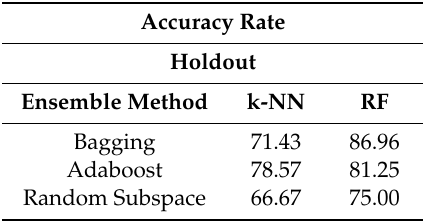
Table 7. Overall performance measure ensemble classifiers for holdout